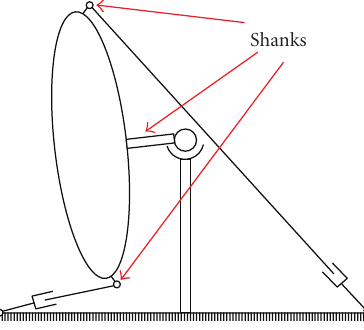
Figure 6: Design features of